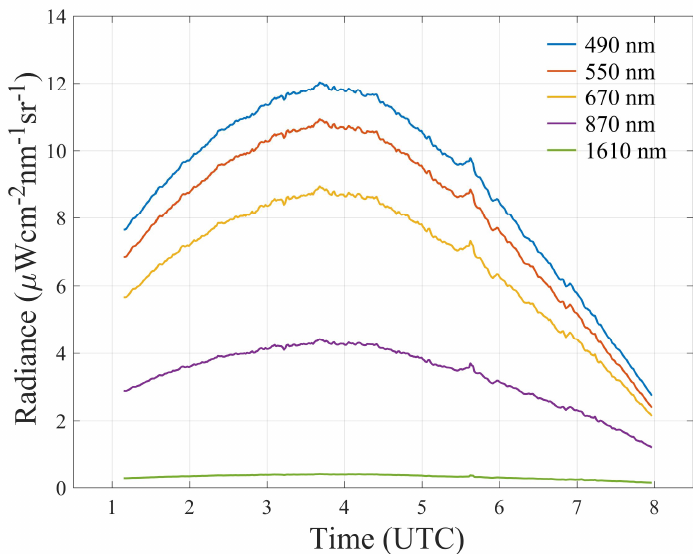
Figure 3. Measurement data of the field experiments located in Beijing (6 November